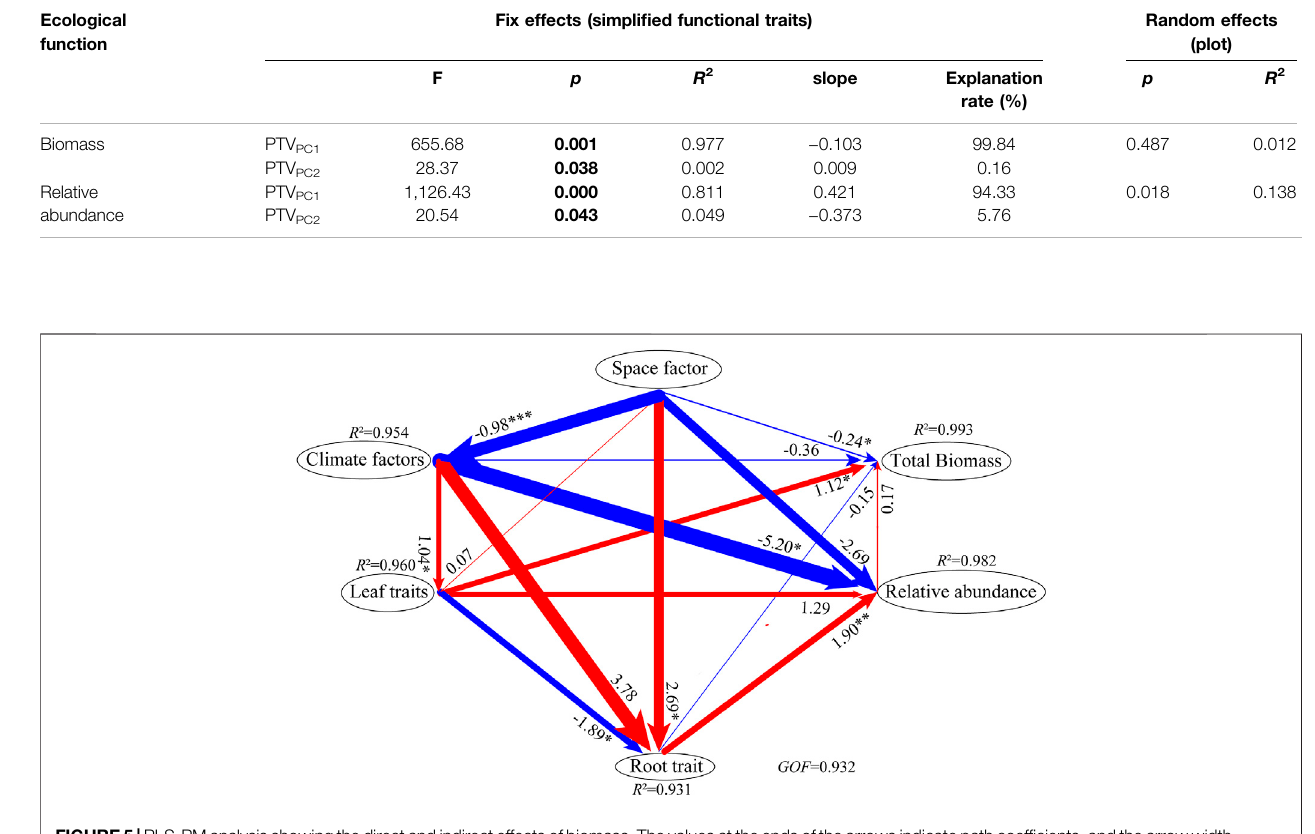
FIGURE5| PLS-PManalysisshowingthedirectandindirecteffectsofbiomass.Thevaluesattheendsofthearrowsindicatepathcoef fi cients,andthearrowwidth represents the strength of the path coef fi cients. The signi fi cance of each path coef fi cient is indicated by the asterisks beside the numbers (* p ＜ 0.05, ** p ＜ 0.01, *** p ＜ 0.001). R 2 , the coef fi cient of determination; GoF , the goodness of fi t. space factor, including elevation; climate factors, including bio1, bio4, bio5, and bio10; leaf traits, includingSLAandSLV;roottrait,includingroot – topratio;relativeabundance,therelativeabundanceof P.fruticosa ;totalbiomass,thetotalbiomassof P.fruticosa .